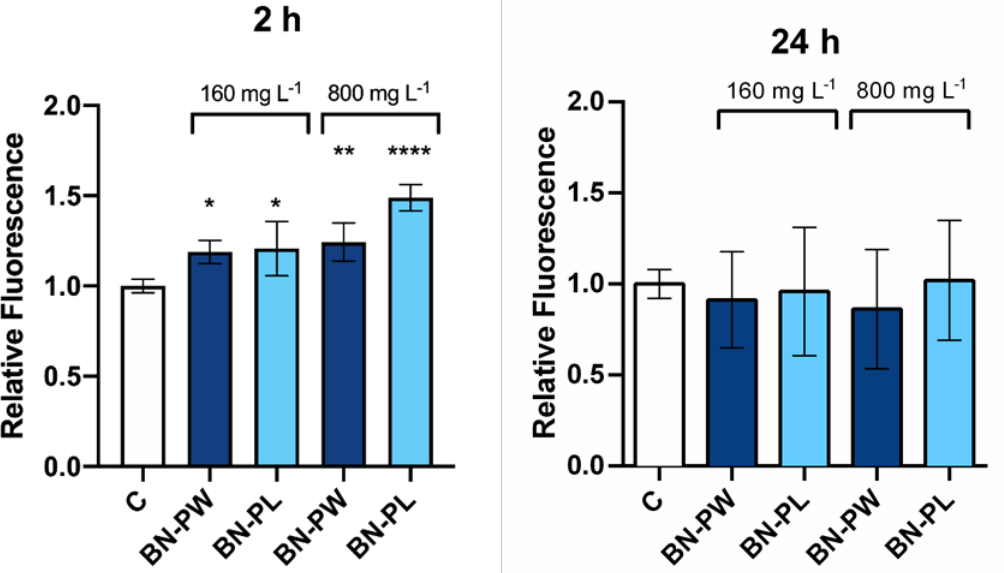
Figure 9. Oxidative stress determination of S. cerevisiae cells exposed to 160 and 800 mg/L of BN-PW and BN-PL during 2 and 24 h. The reported values are expressed in arbitrary units and correspond to the averages of two independent experiments ( ± standard deviation, SD), employing three technical replicates per exposure condition tested in each case. Differences were established using a one-way ANOVA followed by the Dunnett post hoc test to compare every mean with the control, and considered significant at p ≤ 0.05. * p ≤ 0.05, ** p ≤ 0.01, **** p ≤ 0.0001. The figure including the positive control condition (H 2 O 2 (10 mM)) is available as Supplementary Material (Figure S3).